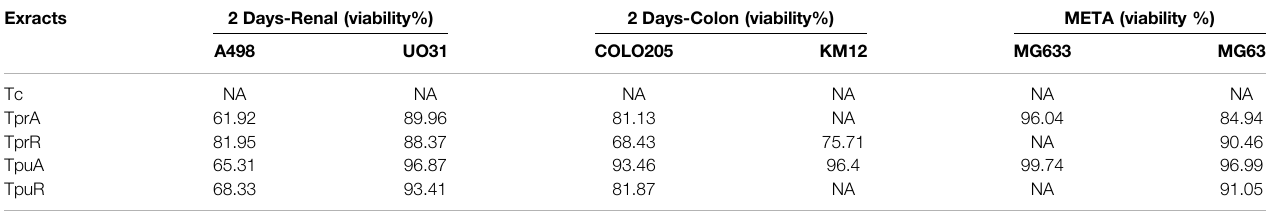
TABLE 4 | Cytotoxic activity results of studied Thymus extracts.